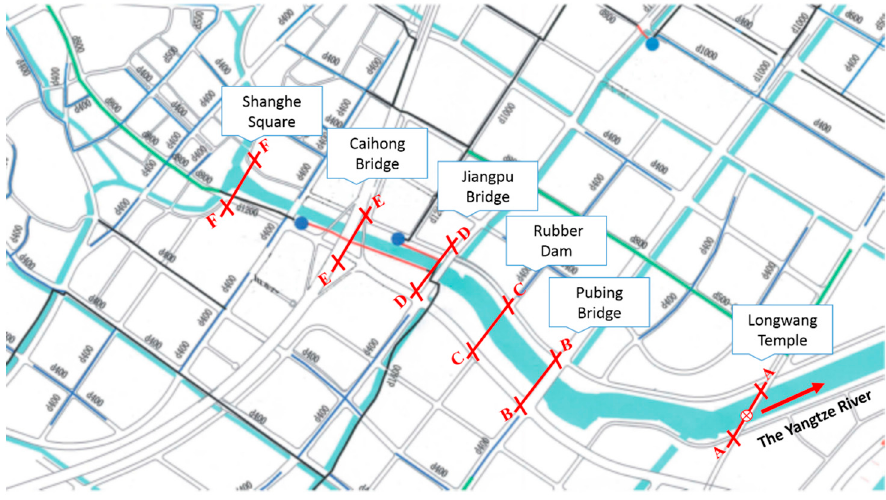
Figure 3. The Location of Monitoring Sections in the Main Channel of Chengnan River.